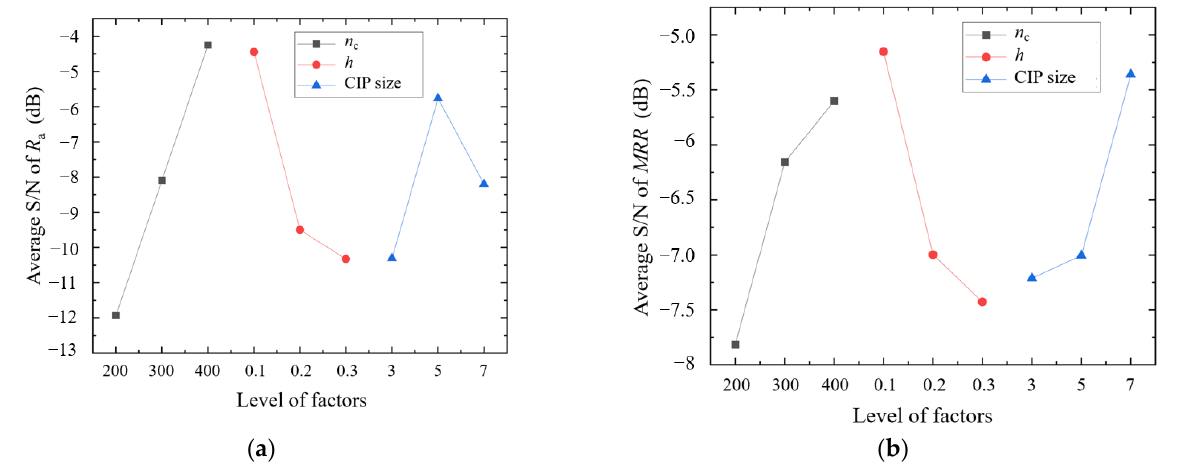
Figure 4. Effects of the revolution speed of the MCF carrier n c , working gap h , and carbon iron particle CIP size on ( a ) R a and ( b ) MRR.